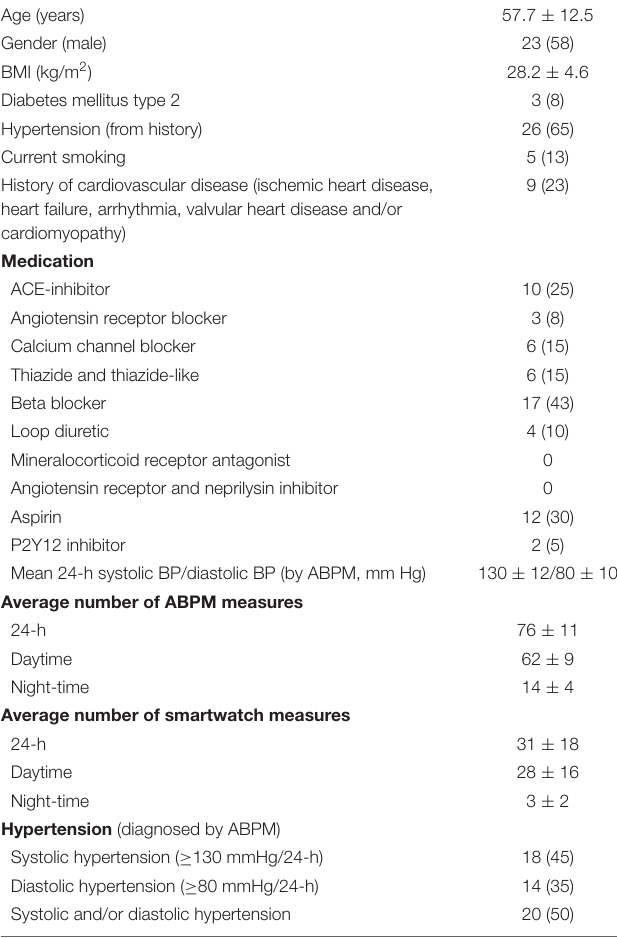
TABLE 1 | Baseline characteristics ( N =